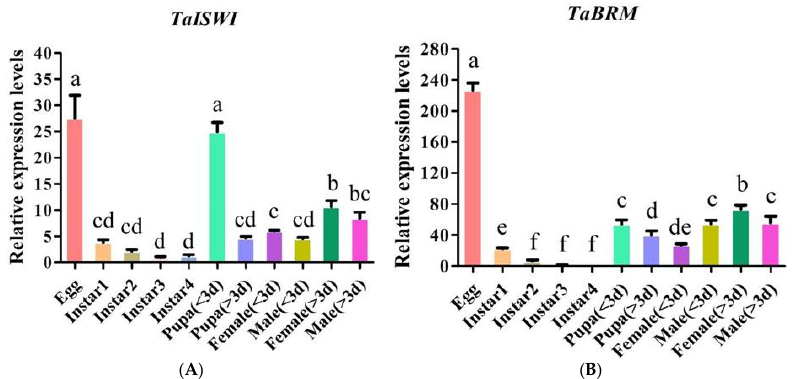
Figure 2. Relative to RpL5, TaISWI ( A ) and TaBRM ( B ) expression levels at different life cycle stages. Relative expression levels are means ± SEM. Bars with different lowercase letters indicate significant differences between treatment means at p <